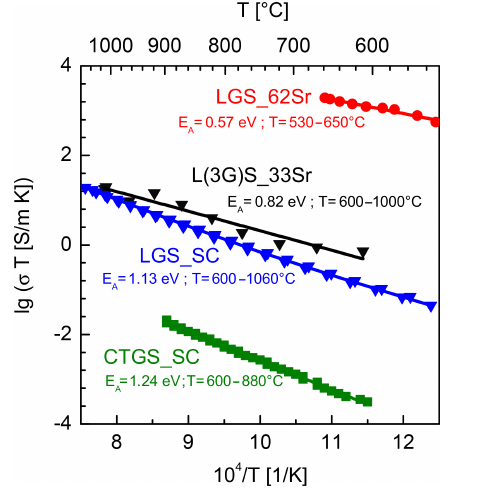
pared using the L(3G)S_33Sr target) compared to the bulk conduc- tivity of CTGS and LGS single crystals (both data sets taken from Suhak et al., 2015) and to the conductivity of a highly Sr-doped LGS sample produced by Sr diffusion (LGS_62 Sr; data set taken from Sauerwald et al., 2011). The depiction of lg( σT ) over the inverse temperature is chosen, since in the high-temperature range conduc- tivity of LGS is governed by oxygen transport and comparability of the data should be